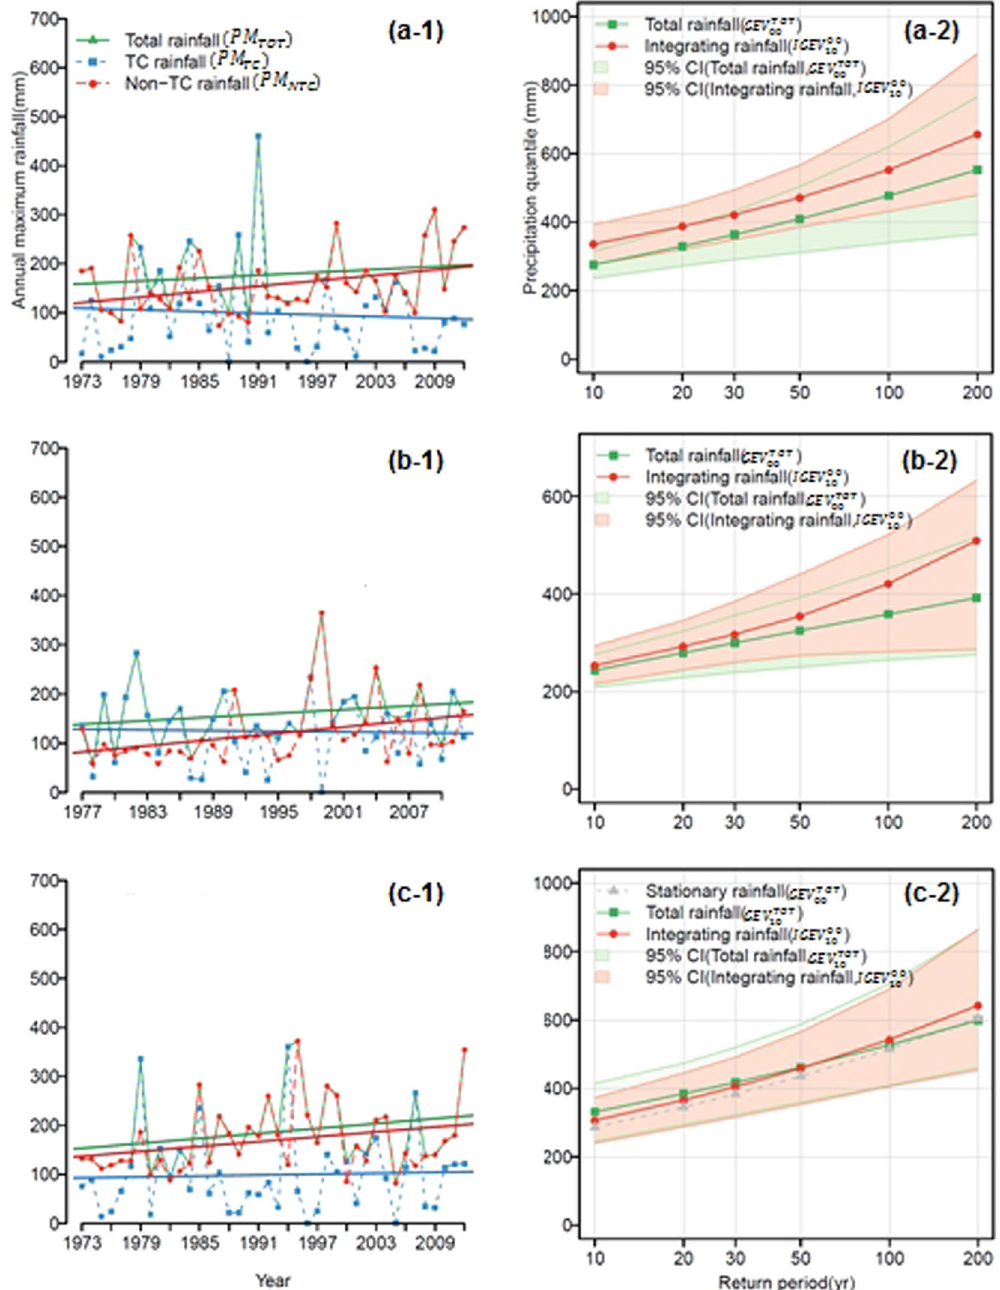
Figure 3. Time series of annual maximum daily rainfall of total rainfall (green dotted line with upward- pointing triangles; PM TOT ), TC rainfall (blue dotted-dashed line with squares; PM TC ), and non-TC rainfall (red dotted-dashed line with circles; PM NTC ) for (a) Busan (station 22), (b) Hachioji (station J3), and (c) Seogwipo (station 29) in the left panels ( a-1 , b-1 and c-1 ). The straight lines indicate the linear fit to annual maximum daily rainfall. The right panels ( a-2 , b-2 and c-2 ) represent the quantiles with 95% confidence intervals estimated by the nonstationary GEV models between total rainfall (green dotted line with squares; ( a-2 and b-2 ) are GEV TOT models, and ( c-2 ) is GEV TOT ) and integrated rainfall (red dotted line with circles; IGEV 1000 ); the gray dotted- 10 dashed lines with upward-pointing triangles in the c-2 indicate the quantiles estimated by the stationary GEV model ( GEV TOT ). Note that (1) the confidence intervals were estimated with the bootstrapping method with 00 1000 resampling; (2) there are some cases that TC rainfall does not occur in a certain year (for example, seogwipo station at 1996, 2005 at ( c-1 )) and the occurrence probability is adopted in these cases as shown in Eqs (6) and (7) with p o to take the non-occurrence of TC rainfall into account for quantile